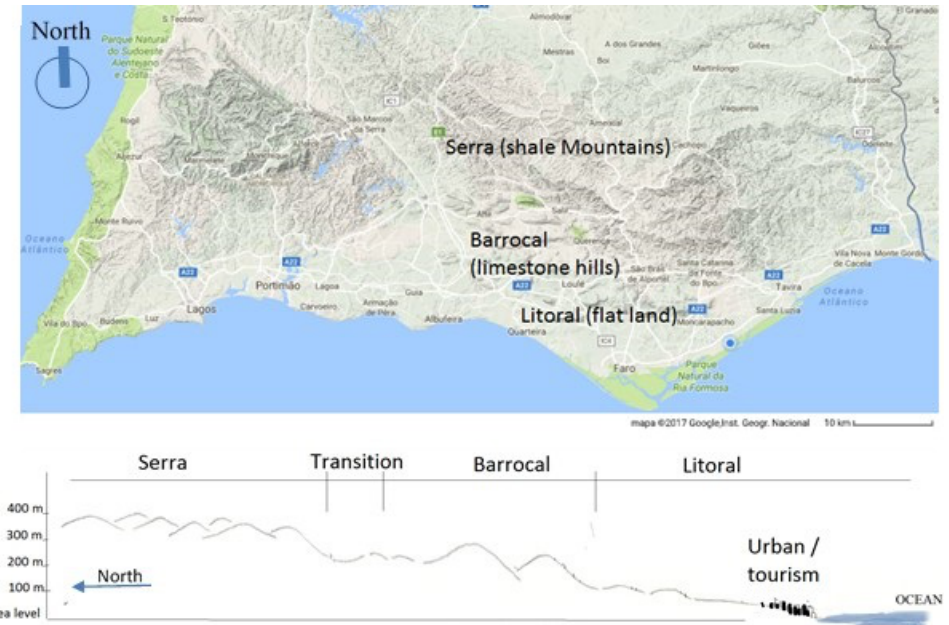
Figure 2: The different types of Algarve relief: Top: digital terrain model (adapted from google maps, 2017); Bottom: profile sketch from North to